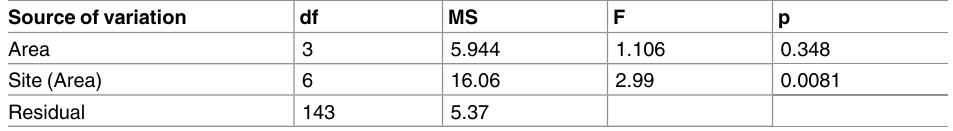
Table 3. Variation in Brix index within and between areas (Nested ANOVA).